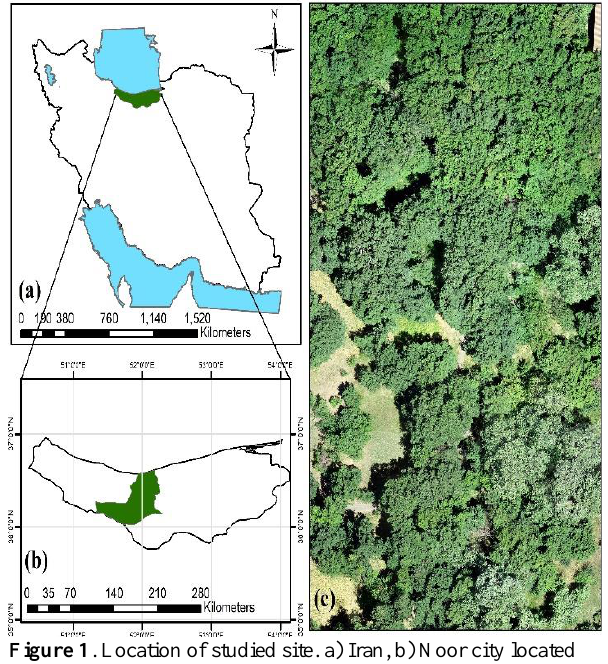
Figure 1 . Location of studied site. a) Iran, b) Noor city located